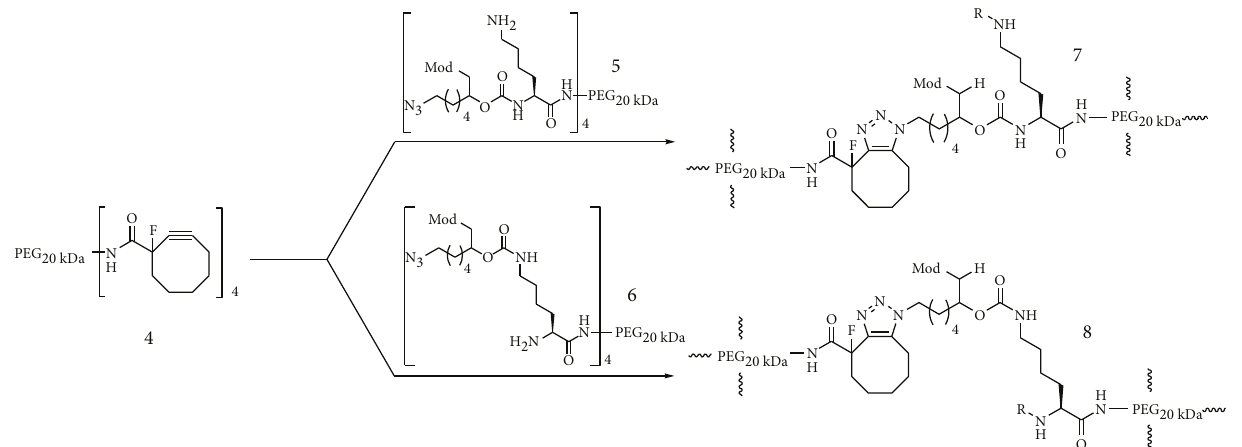
0.10.000.250.500.751.00 Figure 4: In vitro solubilization (degelation) curves of Tetra-PEG hydrogels with crosslinks of di ff erent cleavage rates showing t RG values (Table S1). Crosslink cleavage rate modulators are shown in the legend of the fi gure. The t RG values were determined as an average of four replicates under accelerated conditions of pH 8.4, 9.0, or 9.4 at 37 ° C and converted to pH 7.4 values as described [11].